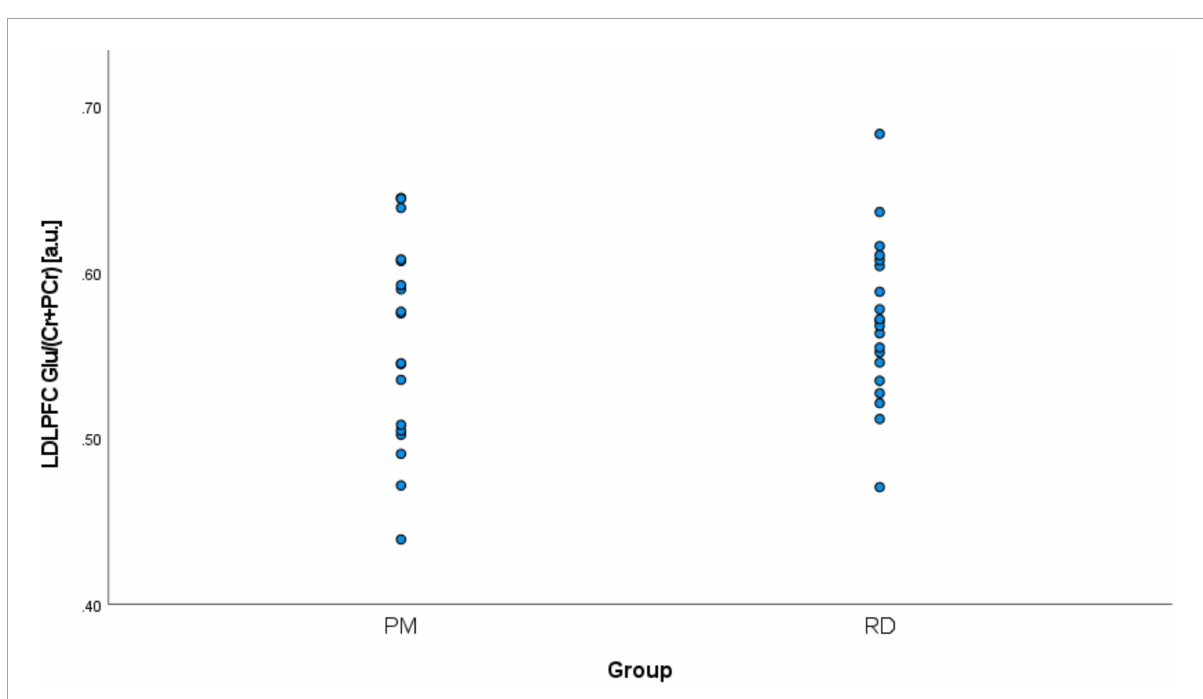
FIGURE5 Comparison of LDLPFC creatine and phosphocreatine-referenced Glu levels in healthy perimenopausal and reproductive-aged women. Glu, glutamate; LDLPFC, left dorsolateral prefrontal cortex; PM, healthy perimenopause; RD, healthy reproductive-aged.